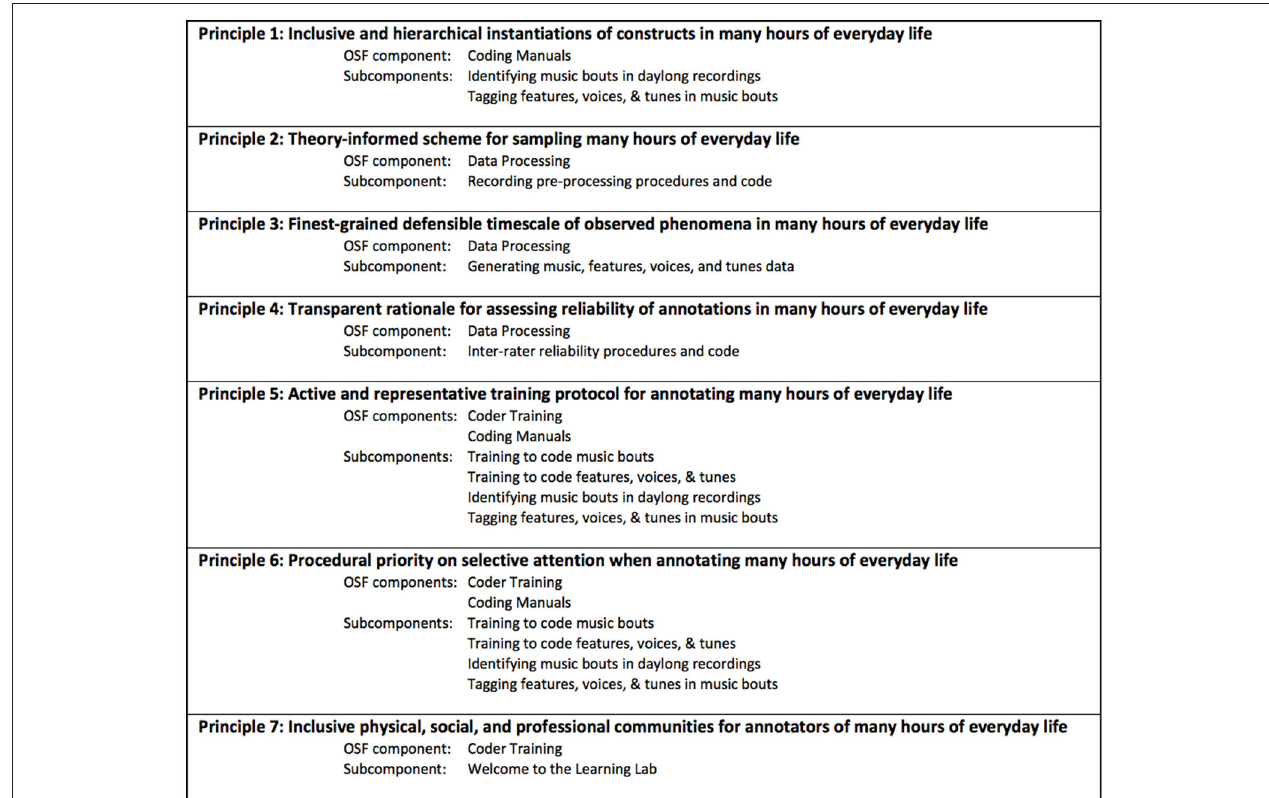
FIGURE 1 | Principles for manual annotation of many hours of infants’ everyday lives. Each principle guides decisions in a research program aiming to quantify everyday ecologies. Materials that support implementing these principles, instantiated in a line of research about infants’ everyday music, are shared on OSF (https:// osf.io/eb9pw/; Mendoza and Fausey, 2019). For an accessible version, please go to